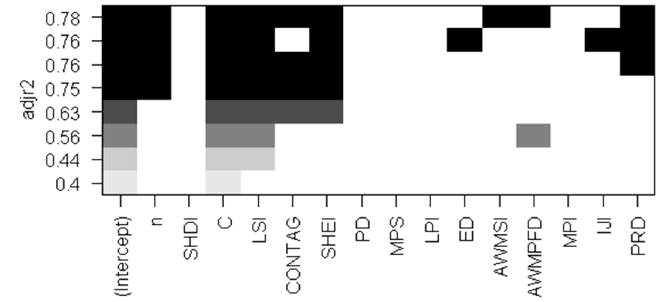
Figure 7. Result of all-subsets regression method.